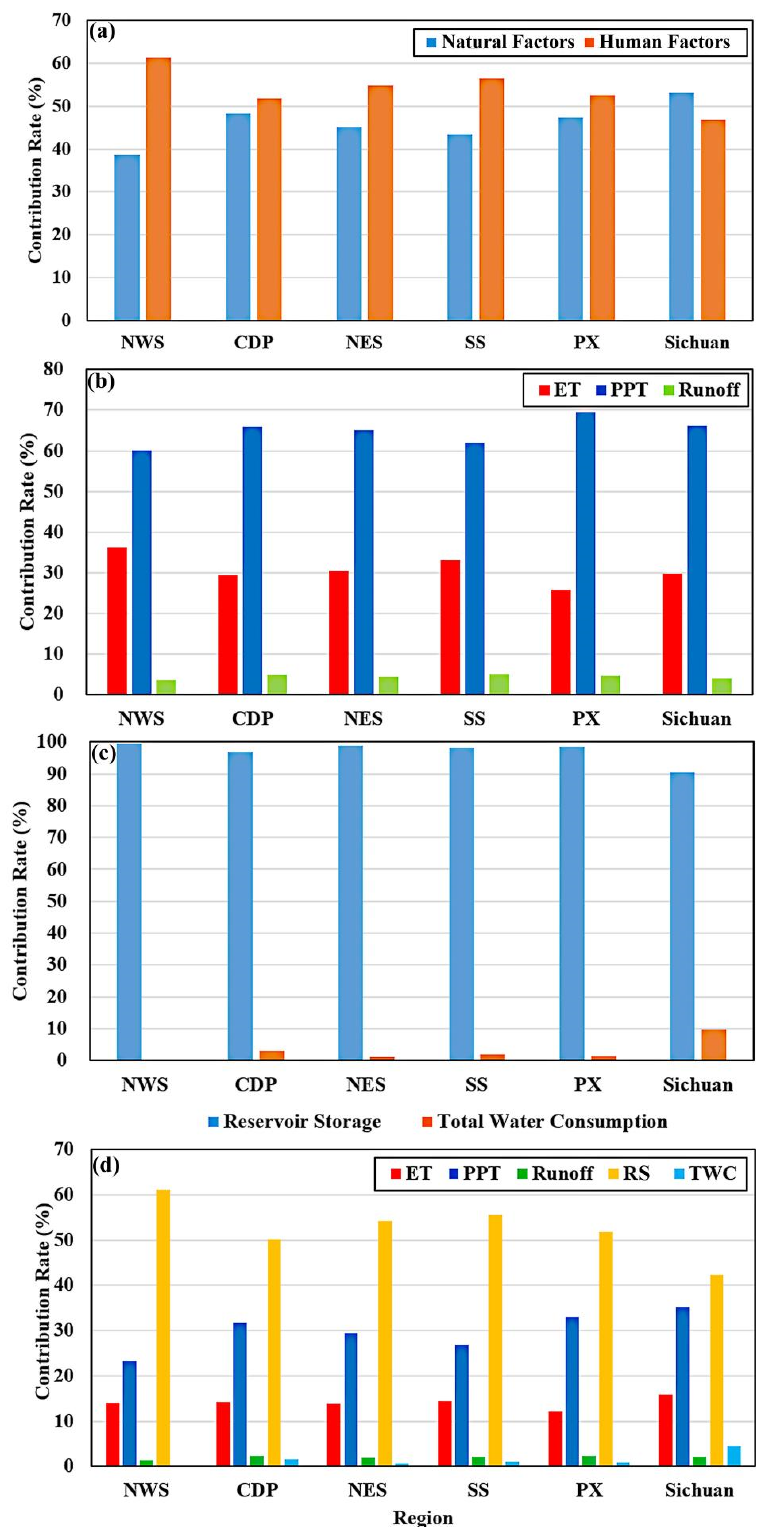
Figure 11. Contribution rate of different factors from climate change and human activities to TWSC , TWSC c , and TWSC h in Sichuan and its five economic zones. RS: reservoir storage; TWC: total water consumption. ( a ) CR of natural and human factors to TWSC ; ( b ) CR of PPT, ET and runoff to TWSC c ; ( c ) CR of reservoir storage and total water consumption to TWSC h ; ( d ) CR of PPT, ET, runoff, reservoir storage and total water consumption to TWSC